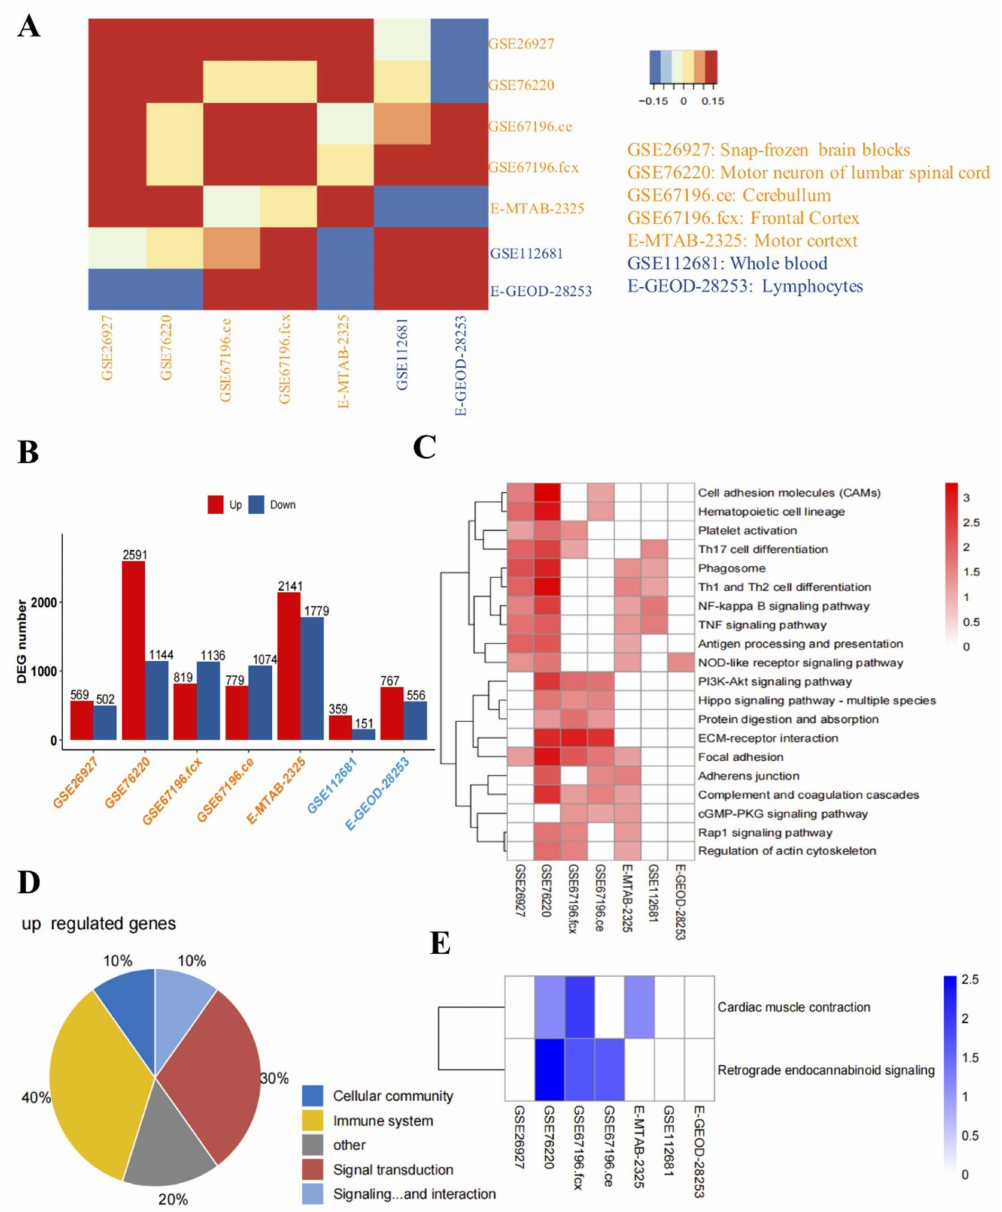
Figure 1. Identification and functional analysis of the differentially expressed genes (DEGs) in the nerve tissue, lymphoid tissue, and whole blood of amyotrophic lateral sclerosis (ALS) patients. ( A ) Correlation analysis of the DEGs in the nerve tissue, lymphoid tissue, and whole blood of ALS patients. The color from blue to yellow to red represents the change of the correlation coefficient from negative to positive correlation. ( B ) Number of DEGs in the nerve tissue, lymphoid tissue, and whole blood of ALS patients. The horizontal axis represents the GEO number. ( C ) Enriched Kyoto Encyclopedia of Genes and Genomes (KEGG) pathways of the genes up-regulated in the nerve tissue, lymphoid tissue, and whole blood. The color from white to red represents the gradual change of p -value from high to low. If p < 0.05 is not satisfied, it is indicated in white. ( D ) Pie chart of the proportion of the genes up-regulated in various KEGG pathways in the nerve tissue, lymphoid tissue, and whole blood of ALS patients. ( E ) Enriched KEGG pathways of the genes down-regulated in the nerve tissue, lymphoid tissue, and whole blood. The color from white to blue represents the gradual change of p -value from high to low. If p < 0.05 is not satisfied, it is indicated in